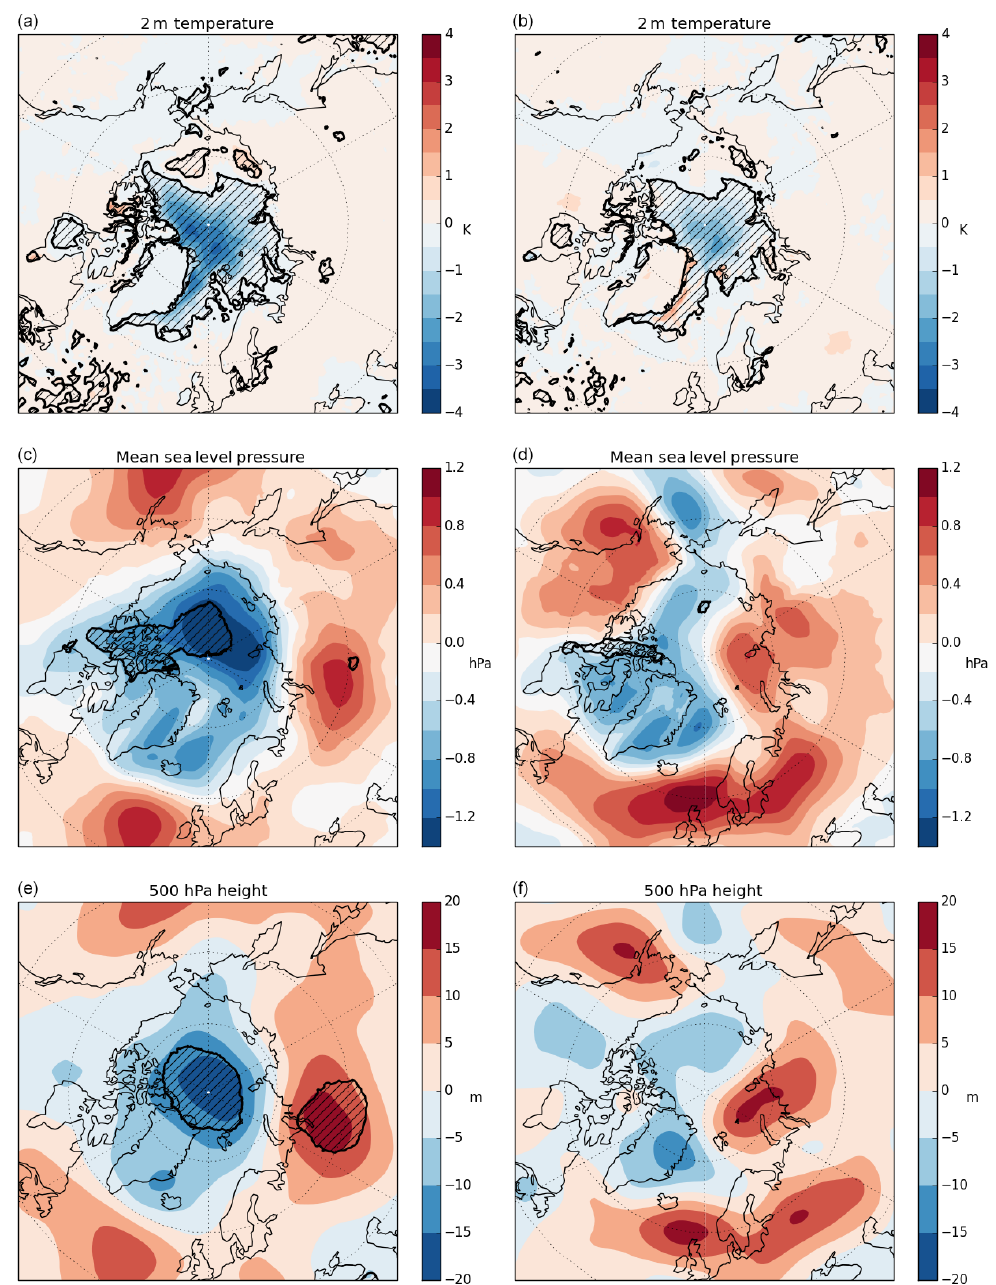
Figure 8. Differences in mean fields (a, c, e) and differences in root-mean-square-error (RMSE; b, d, f ) between the ThkDA and CTRL September predictions averaged over all ensemble members for the 5-year period 2011–2015. Fields shown are (a, b) near-surface 2m air temperature (T2M; K); (c, d) mean sea level pressure (MSLP: hPa); (e, f) 500hPa geopotential height (z500; m). Differences are calculated as ThkDA–CTRL meaning that areas of blue and red denote that ThkDA predictions/RMSEs are lower and higher, respectively. Black contours and hatching denote areas where differences are significant at the 95% level as determined using a Mann–Whitney U test. Further details can be found at the beginning of Sect.